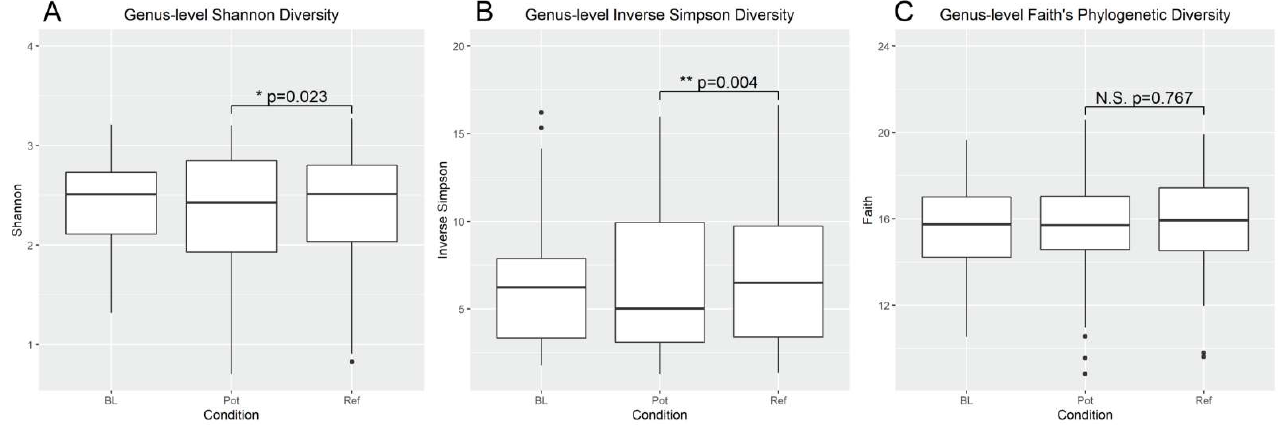
Figure 2. Alpha diversity analysis. The microbiotas of all participants were assessed for microbial diversity at baseline and during each diet condition. Shannon diversity, Inverse Simpson diversity, and Faith’s Phylogenetic Diversity were assessed for each. Statistical comparisons were made between the potato and refined grain conditions by a mixed effects model with participants used as a random effect. * indicates p < 0.05, ** indicates p <